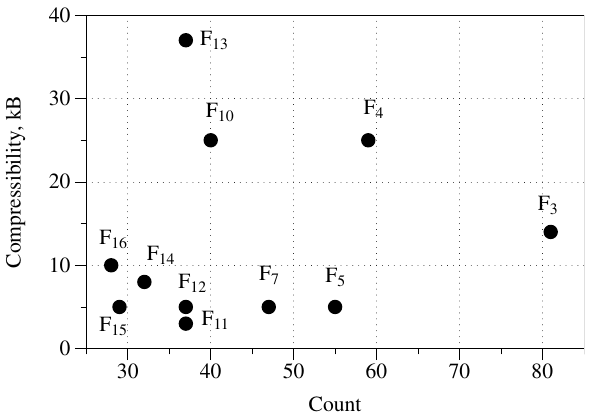
Figure 6. Frequency of functions from Table 1 versus LZ complexity, measured via compressibility of the space- time configurations of cellular automata governed by the functions. Functions F 1 , F 6 , F 8 and F 9 are not displayed because their LZ is near